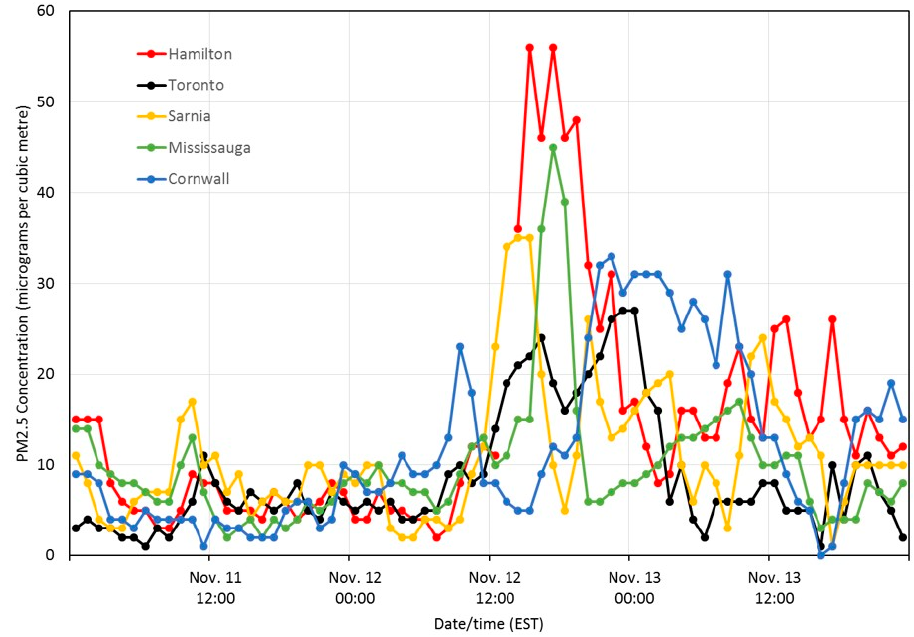
Figure 12. PM2.5 hourly concentrations at various locations, 11–13 November 2010.